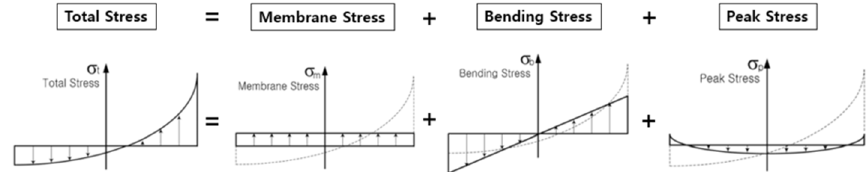
Figure 4. Decomposition of the linear stress distribution. Reprinted with permission from ref. [21].